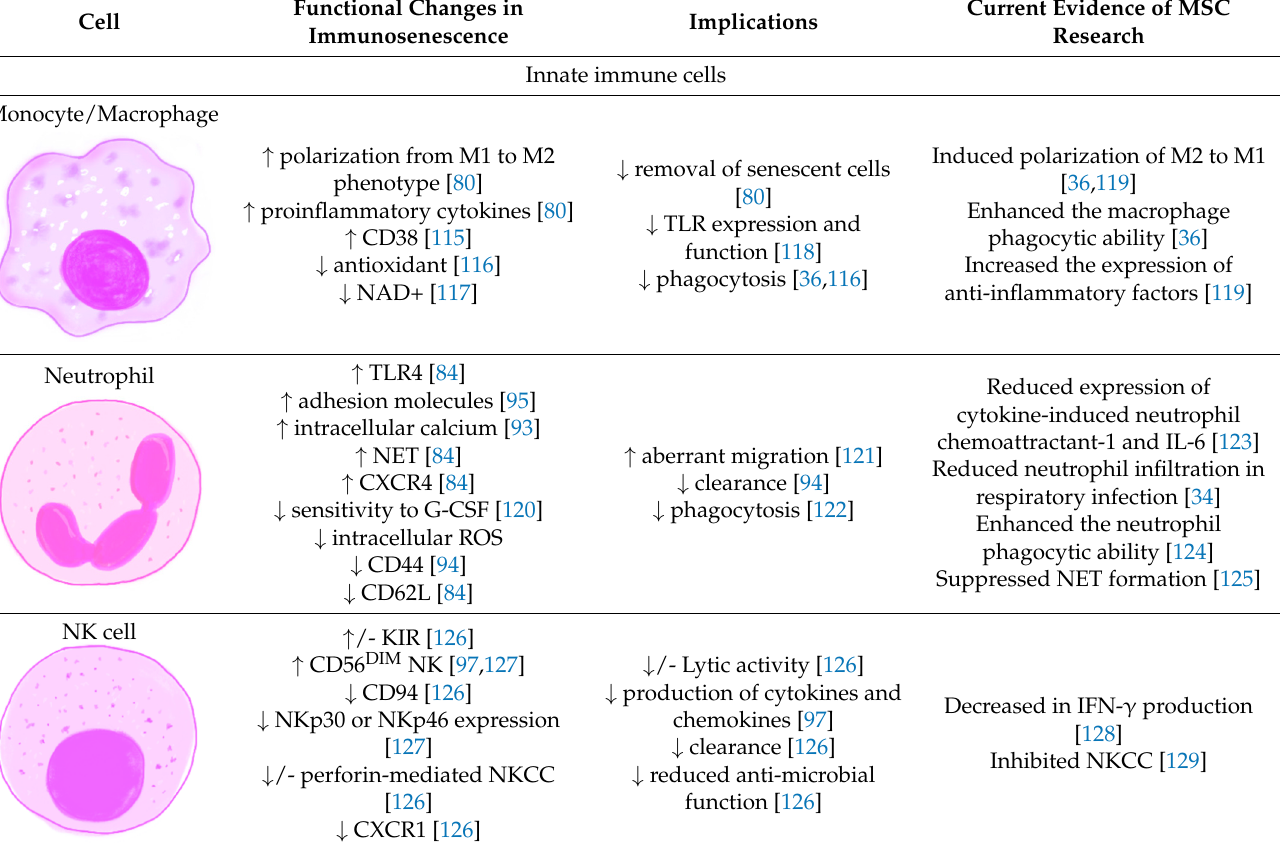
Table 1. The functional changes of immune cells in immunosenescence and the current evidence of MSC that improved the function of the aged cells. (‘ ↓ ’ = decrease; ‘ ↑ ’ = increase; ‘-‘ = no change). Cell Functional Changes in Current Evidence of MSC Cell Implications Immunosenescence Research Innate immune cells Monocyte/Macrophage